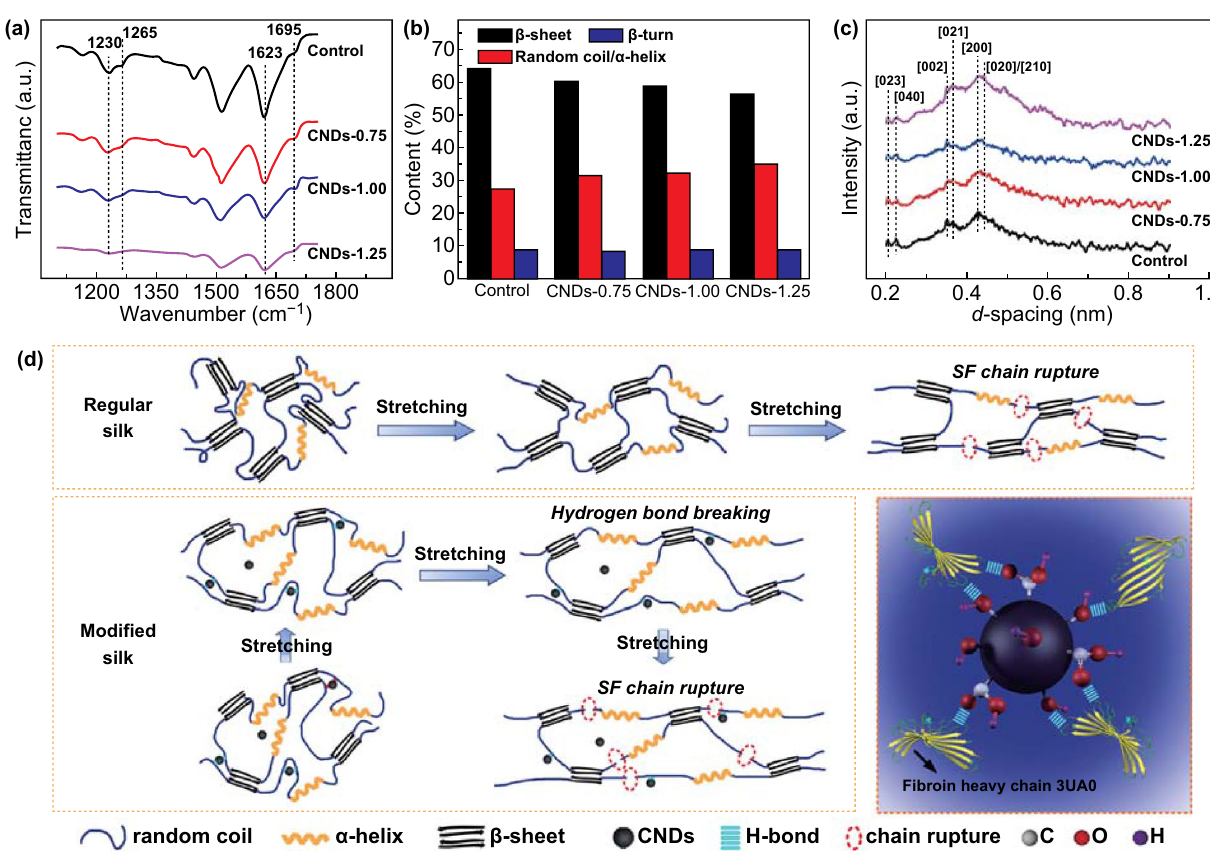
Fig. 3 Crystalline structure and proposed reinforcing mechanism of multi‑functional silk from silkworms fed CNDs. a – c FTIR spectra ( a ), content of secondary structures ( b ) obtained based on the amide I band in FTIR spectra, and 1D‑WAXD patterns ( c ) of degummed silks. d Sche‑ matic diagram illustrating reinforcing mechanism of silks by incorporation of CNDs